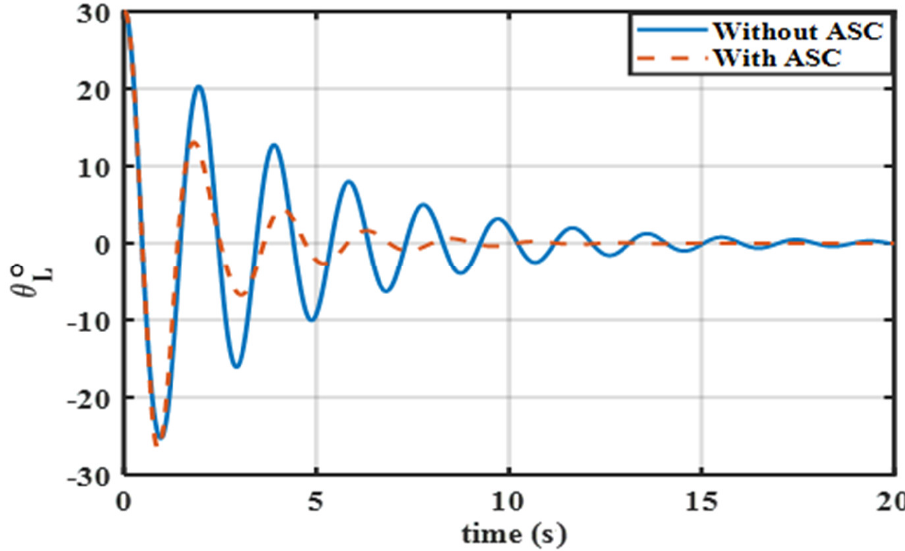
Figure 26. Time history of the out-of-plane load swing angle during hover using numerical simula- tions.